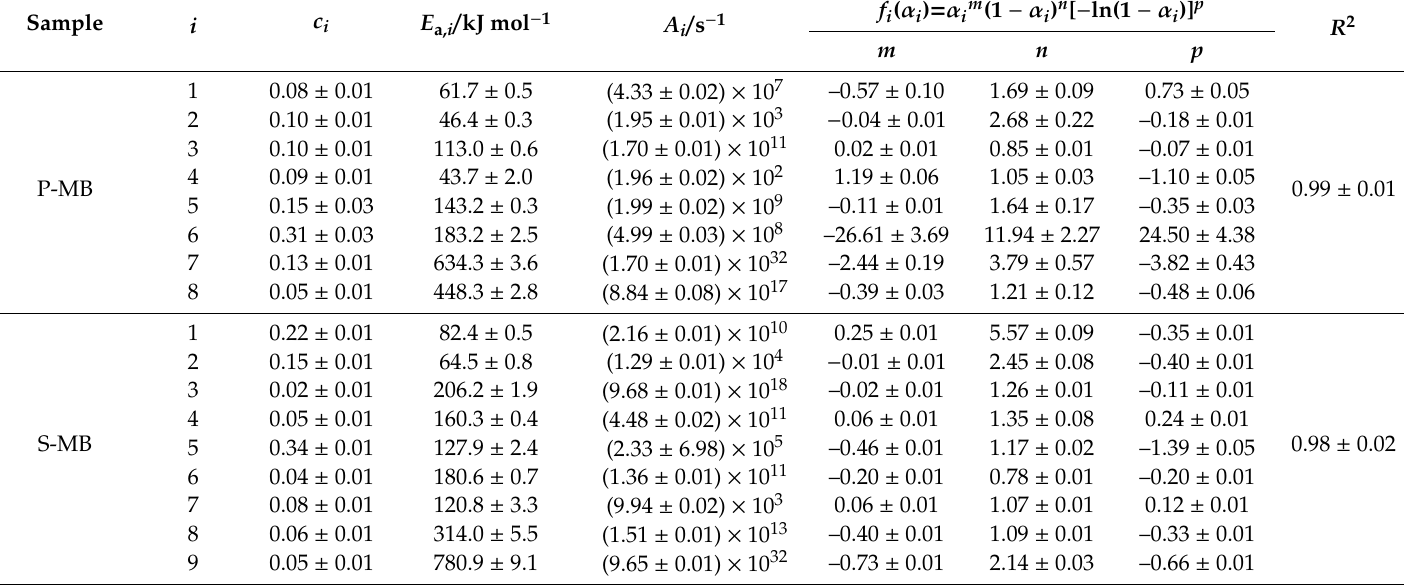
Table 2. Kinetic parameters for each reaction step for the thermal decomposition of MB, as determined by